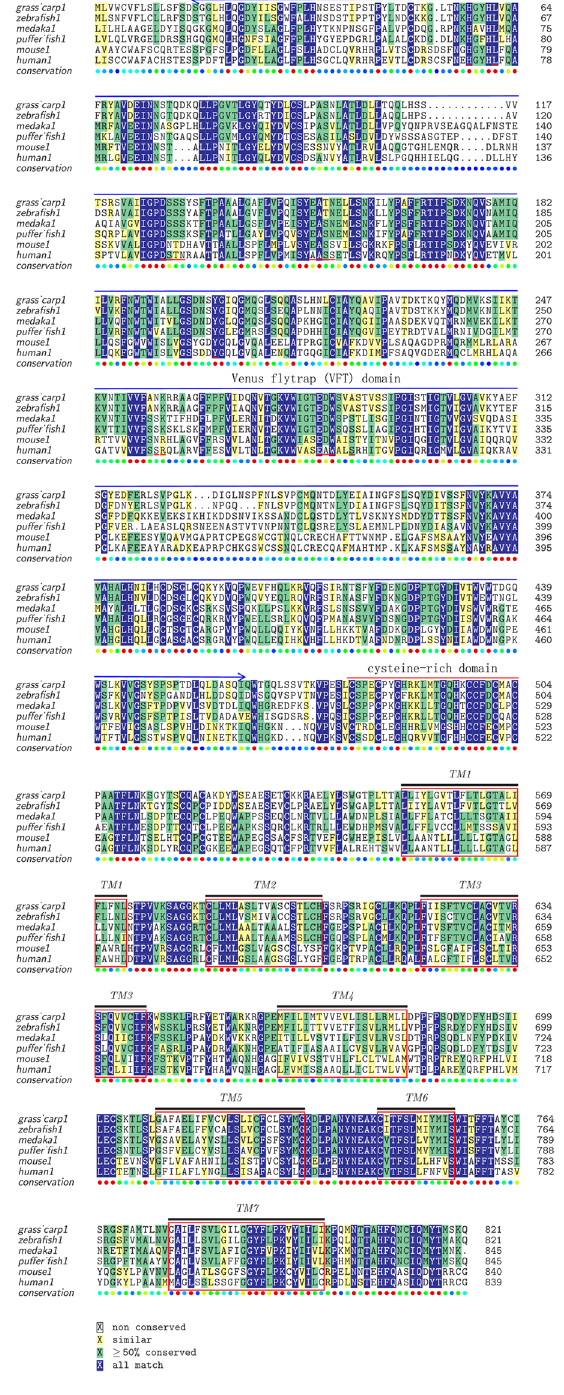
Figure 1. Multiple amino acid sequence alignment of T1R1. The colors indicate that the amino acids in that column were identical across all species. A long extracellular amino-terminal domain called a Venus flytrap module (VFTM) containing the ligand binding pocket was marked with blue line. A cysteine-rich domain (CRD), which links the VFT and 7TM domains was marked with red line. Transmembrane domains (TMD) of grass carp T1R1 were marked with red boxes. Amino acid sequences are available from the DDBJ/EMBL/ GenBank databases shown in Table